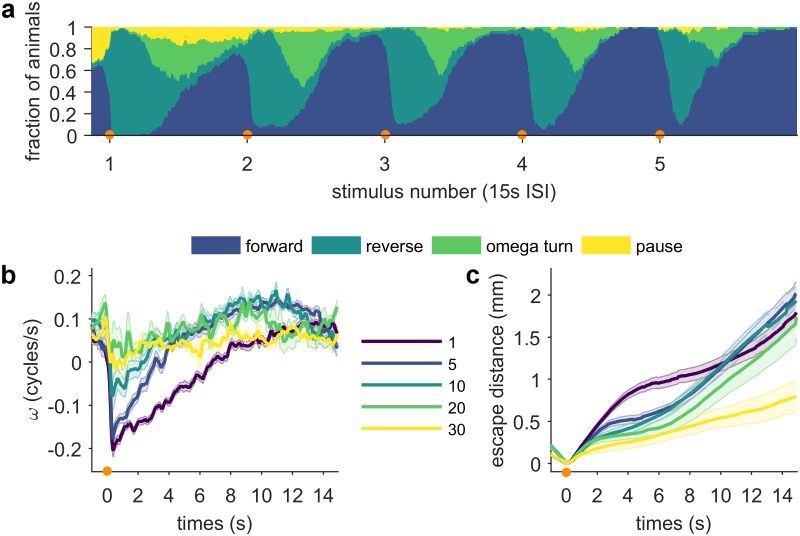
C. elegans sensory processing of thermal stimuli habituates with repeated encounters with a stimulus.IR laser stimuli (100 ms 75 mA, focused by 75 mm lens) were automatically targeted to the animal’s head every 15 s (indicated by orange circles). (a) Fraction of animals occupying each of the four behavioral states after repeated stimuli. Note the decreasing proportion of animals in the turn and pause state for the first several stimuli. n ≥ 14. (b) Mean phase velocity of animals that have been stimulated 1 (purple), 5 (blue), 10 (teal), 20 (green) and 30 (yellow) times. Shaded regions indicate the standard error of the mean. (c) Escape distance. Shaded regions indicate the standard error of the mean. Full ethograms shown in S6 Fig.